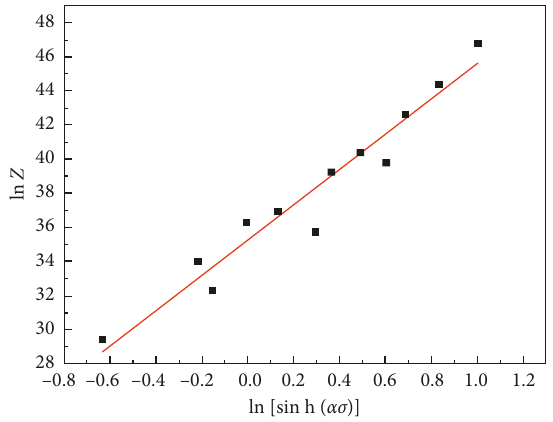
Figure 4: Curve of ln Z − ln [ sin h ( ασ )] .